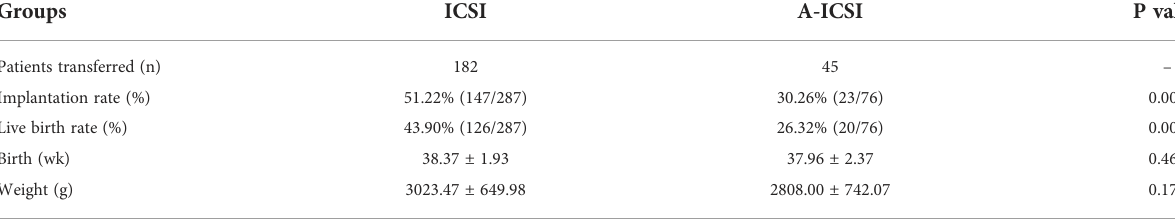
TABLE 6 Effect of A23187 activation on pregnancy outcome and offspring after an ICSI cycle. Groups